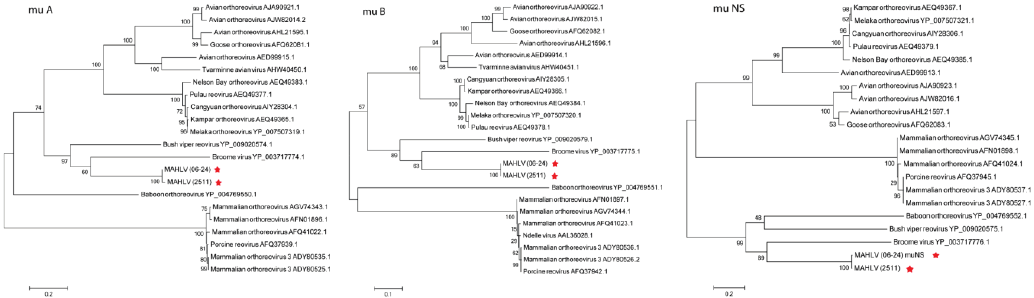
Figure 9. Molecular phylogenetic analysis by Maximum Likelihood method showing the placement of MAHLV within the Orthoreovirus genus using amino acid sequences of the ORFs in the three medium segments, M1, 2 and 3 coding for proteins mu A, B and NS.